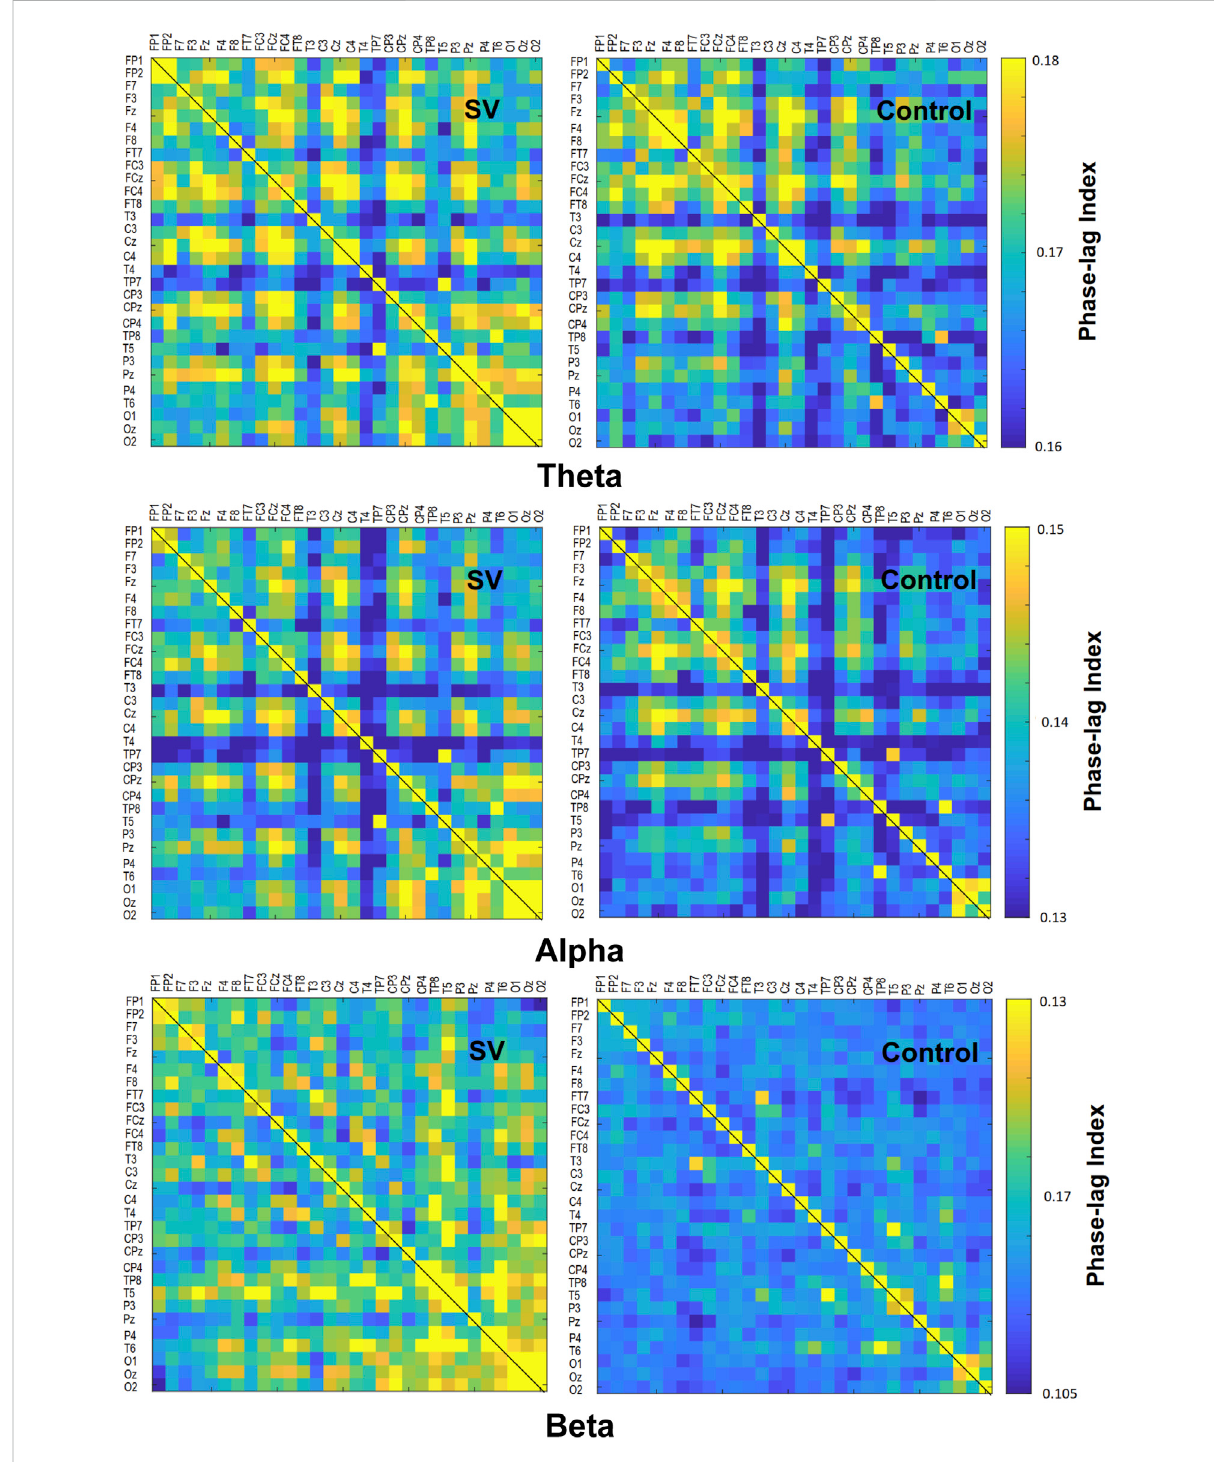
FIGURE 3 The adjacent matrices of t values contrasting the phase-lag index (PLI) values of all electrode pairs in the theta (4 – 7 Hz), alpha (8 – 12 Hz), and beta (13 – 35 Hz) bands between the SV and control conditions. A contrasting wiring diagram on the scalp shows the topological distributions of the supra-threshold connectivity tuned to stroboscopic vision (SV vs. Control) (| t | > 2.898, p < 0.005). (Red line: SV > Control, p < 0.005; Blue line: SV < Control, p <